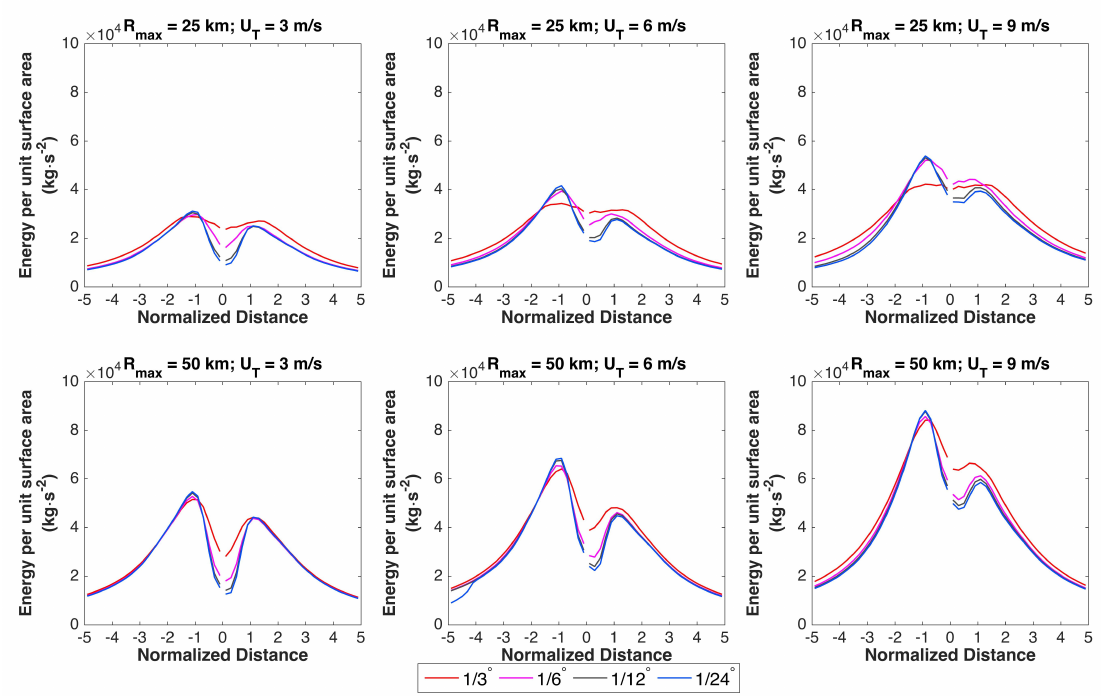
Figure 7. Average wave energy within a half-annulus area (front and rear) at different radii from the storm center under the six idealized storms from WW3. Red, magenta, black and blue lines denote results from the coarsest to the highest resolution.